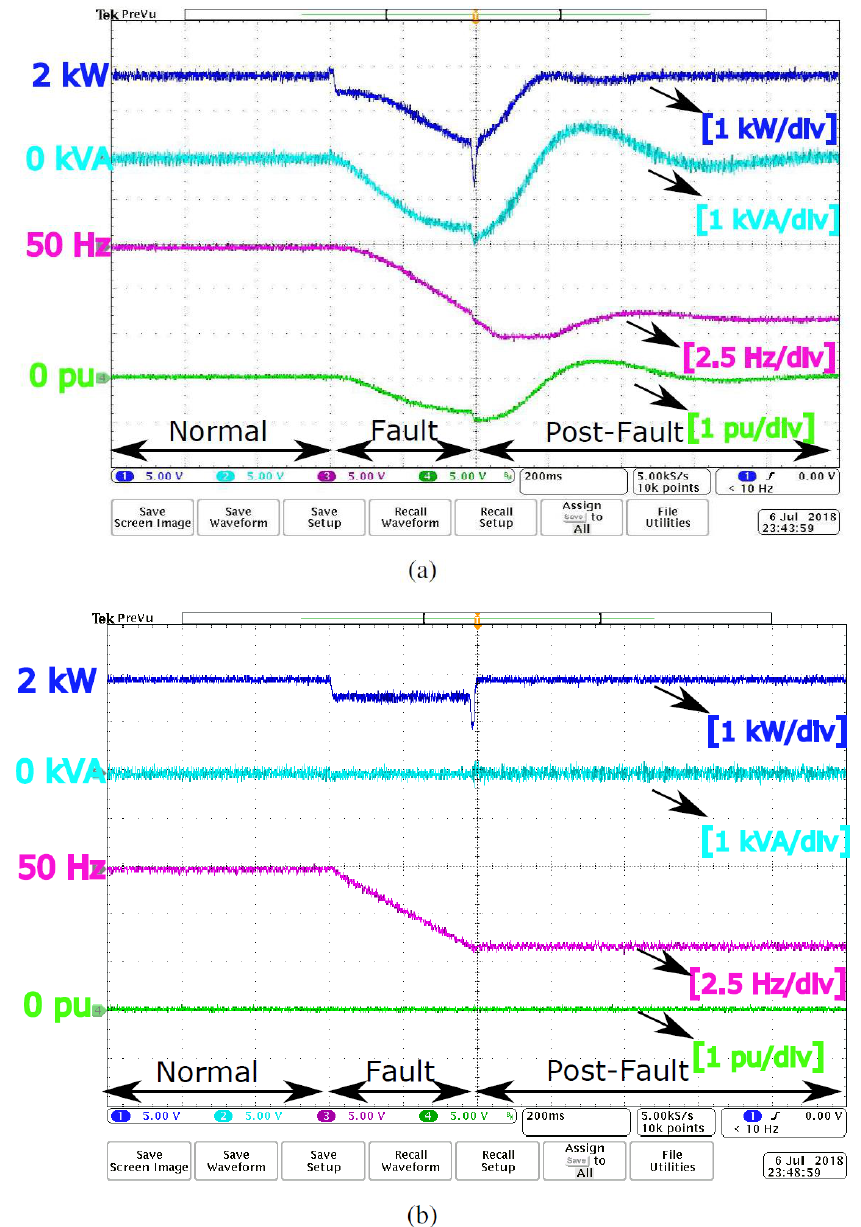
Figure 15. Experimental results with fault induced ROCOF of 10 Hz/s—( a ) Inverter response during fault induced fast ROCOF with low bandwidth PLL parameters, ( b ) Inverter rersponse during fault induced fast ROCOF with high bandwidth PLL